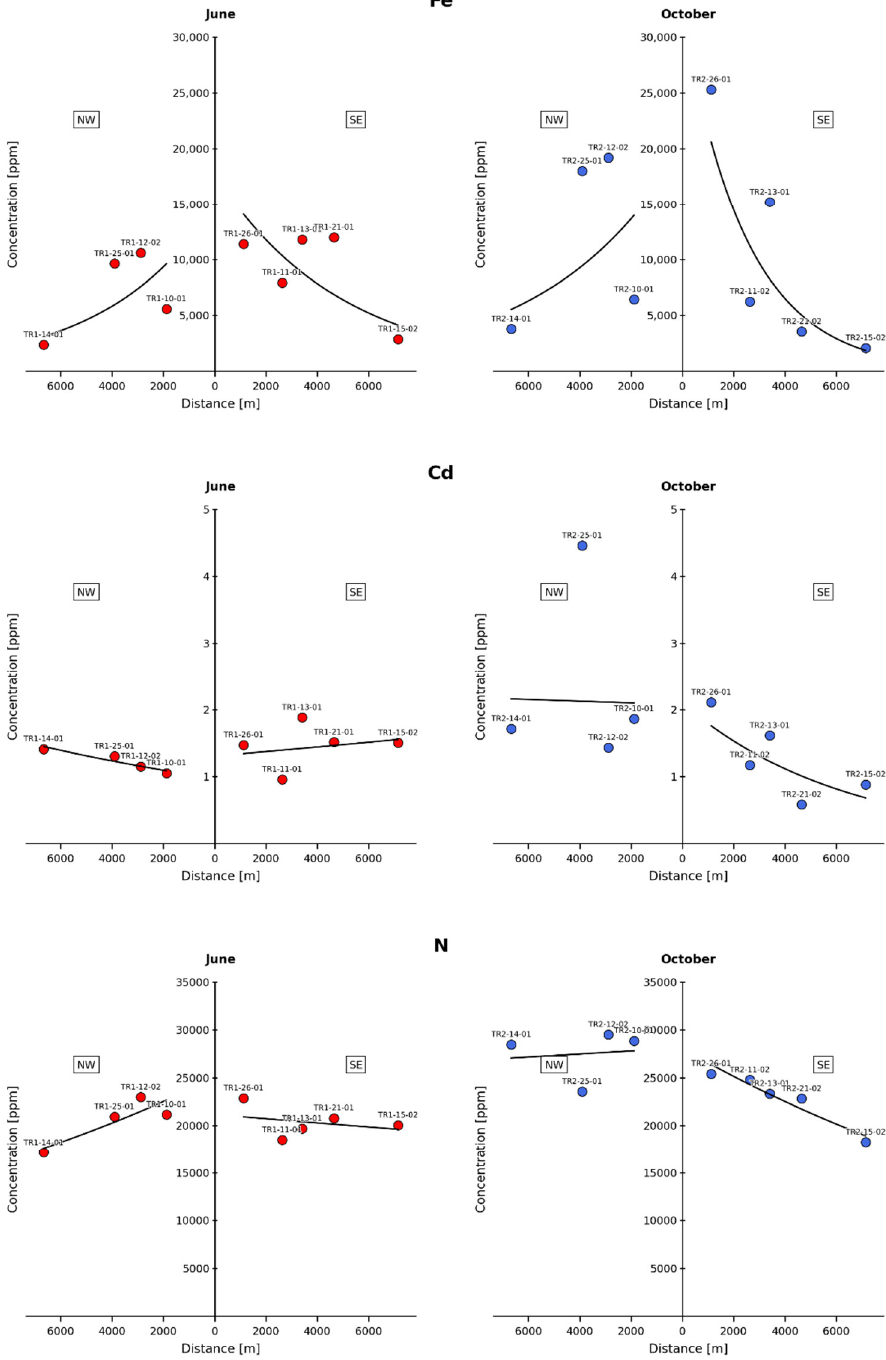
Figure 6. Gradients of concentrations of the assessed elements in terrestrial mosses collected in the surroundings of the Tˇrinec Iron and Steel